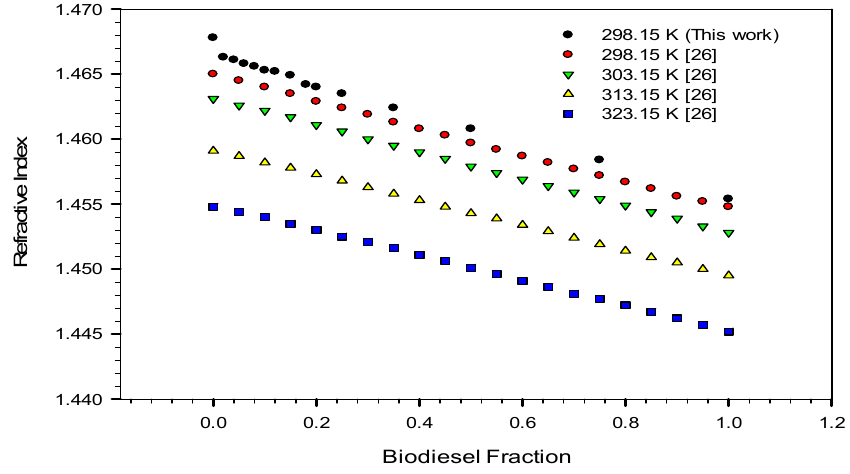
Figure 6. Refractive Index biodiesel blend with predicted value.